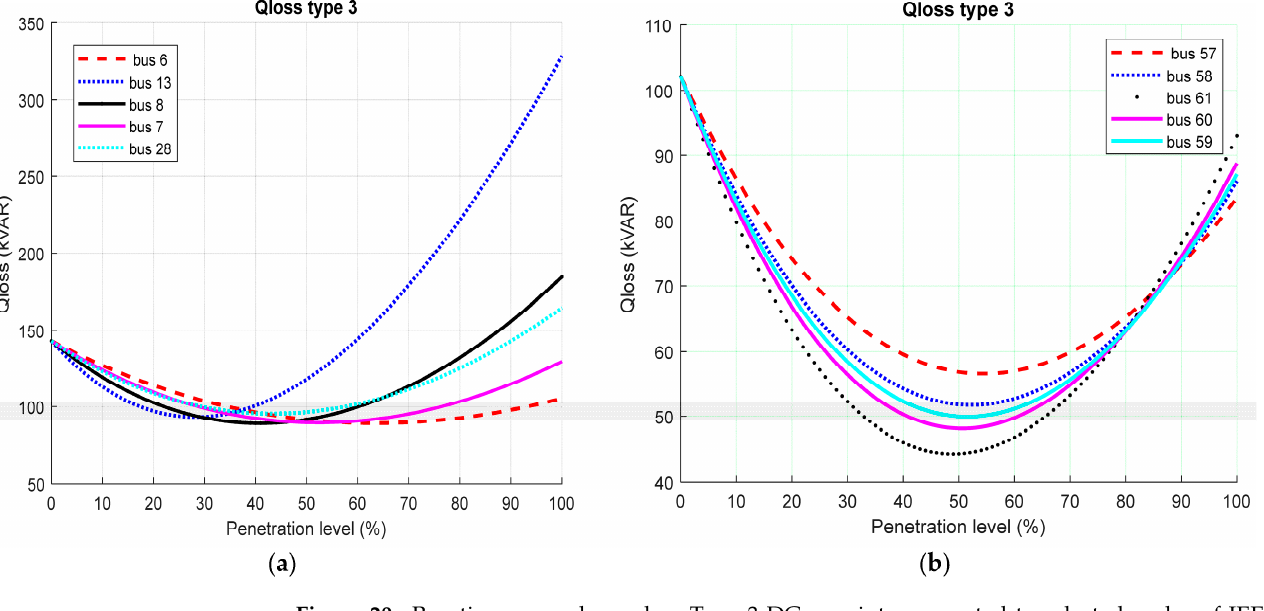
Figure 20. Reactive power loss when Type 3 DG was interconnected to selected nodes of IEEE ( a ) 33-bus ( b ) 69-bus RDNs.